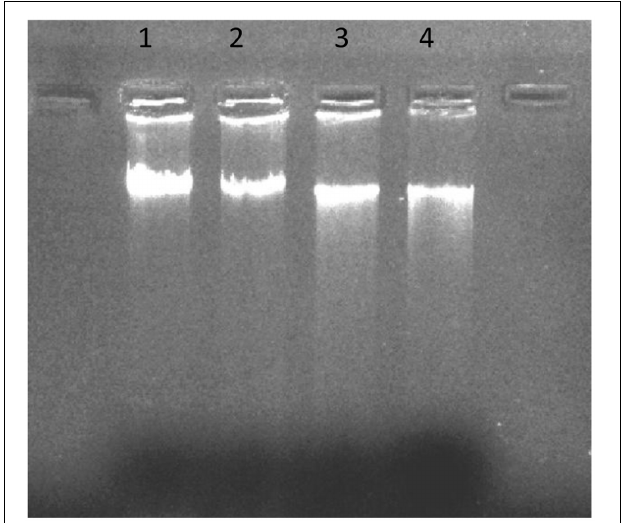
FIGURE 10 | DNA fragmentation following treatment with H-AgNPs. Lane 1 shows DNA control sample of untreated bacterial cells, lane 2 DNA of bacterial pellet treated with the lowest concentration (0.45 mg per ml) of H-AgNPs, lane 3 DNA of bacterial pellet treated with H-AgNPs (0.9 mg per ml), and lane 4 contains the DNA of bacterial pellet treated with H-AgNPs (1.8 mg per ml).